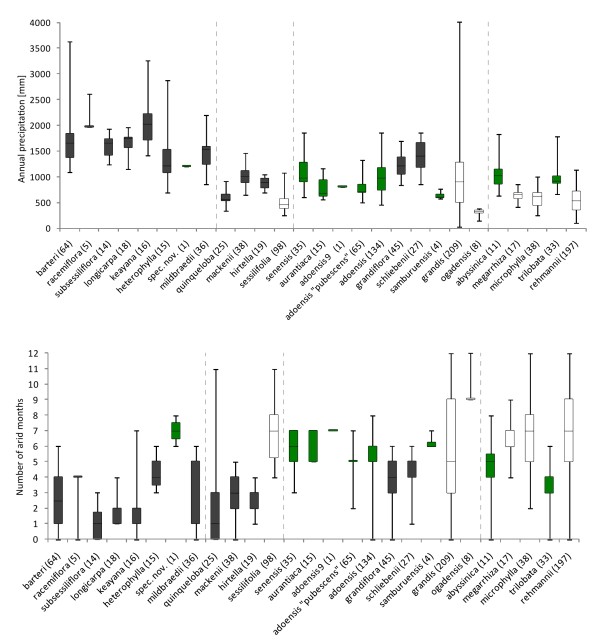
Precipitation variation of species in the genus Coccinia. Box-and-whisker plots displaying the median, upper quartile, and lower quartile (box) and range of extremes (whiskers) of the precipitation tolerances (mean annual precipitation and number of arid months) of 1189 georeferenced herbarium collections. Numbers of collections for each species are given in the parentheses following the species names, and the species order follows the phylogeny in Figure 4. Dashed lines separate the clades/groups, and colors indicate the biomes: black = forest, green = woodland and humid open habitats, and white = semi-arid habitats.